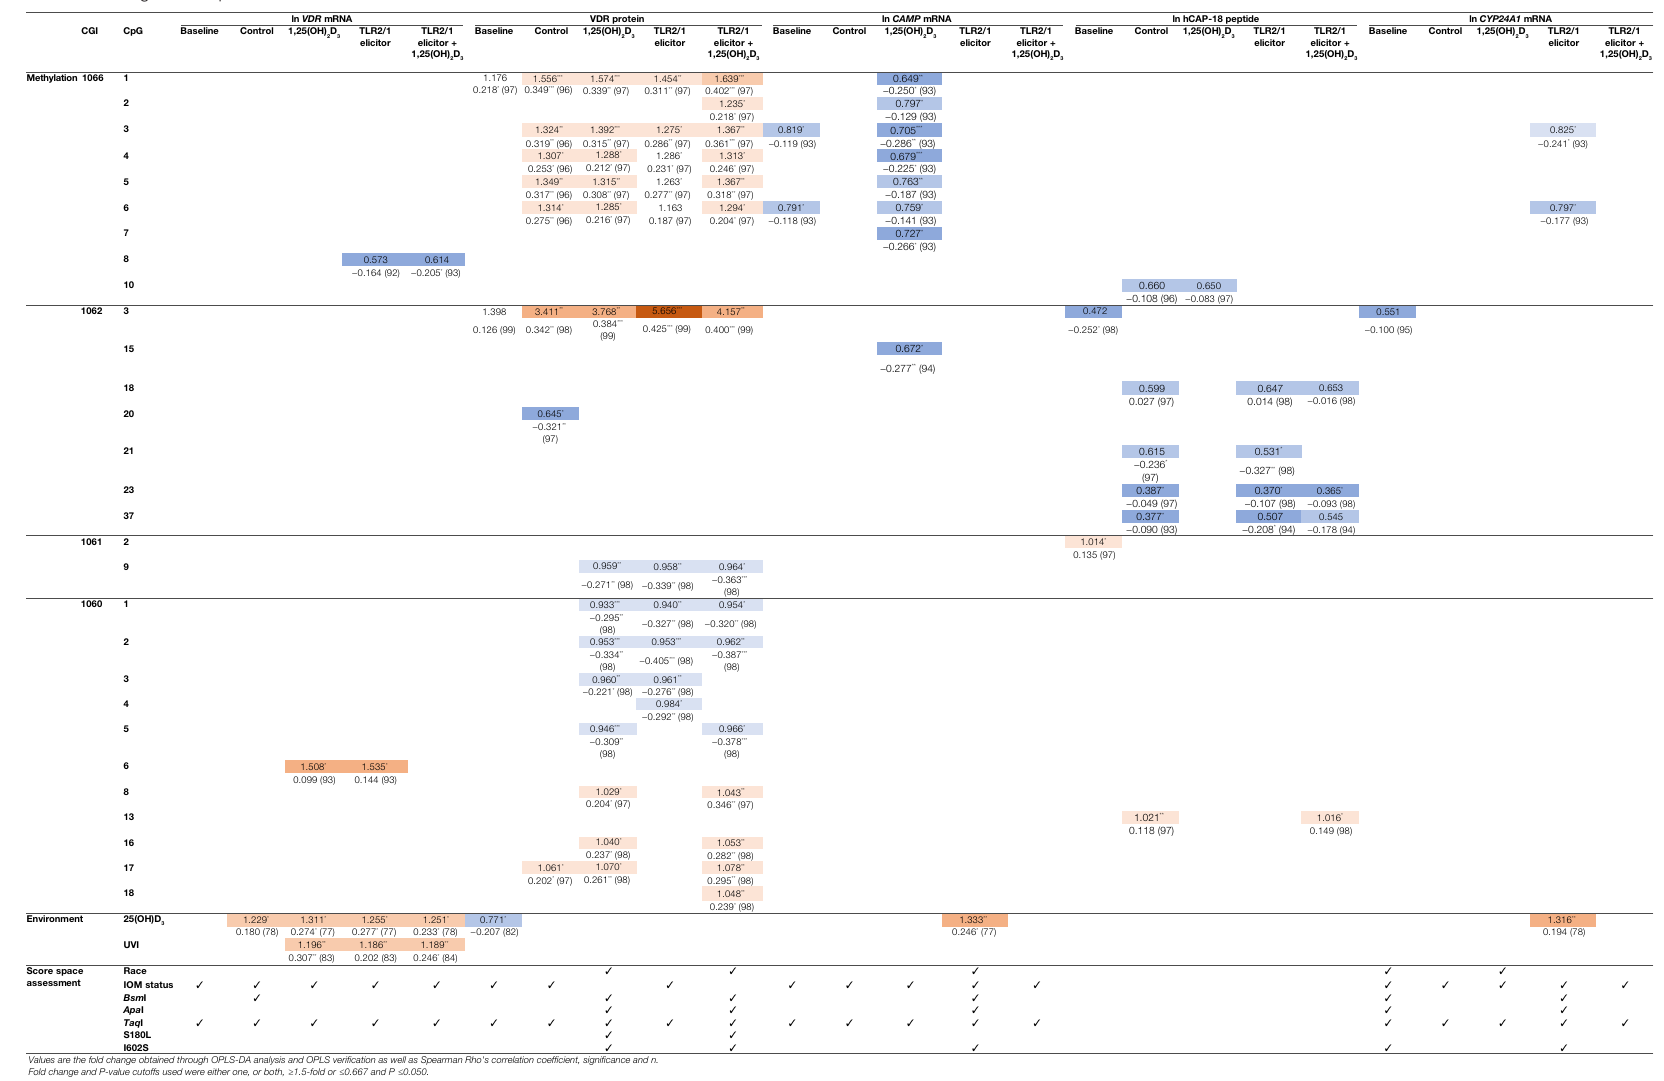
Values are the fold change obtained through OPLS-DA analysis and OPLS verification as well as Spearman Rho's correlation coefficient, significance and n. Fold change and P-value cutoffs used were either one, or both, ≥1.5-fold or ≤0.667 and P ≤0.050. * P ≤ 0.050, ** P ≤ 0.010 and *** P ≤ 0.001. Different colors represent the increase (orange) or decrease (blue) in the logarithmic fold change of functional variables as indicated in the color index; scaling the spread of values for each functional variable in thirds, above or below zero. The fold change in VDR protein upon elicitation, discriminated by CGI 1062 CpG 3 was beyond this